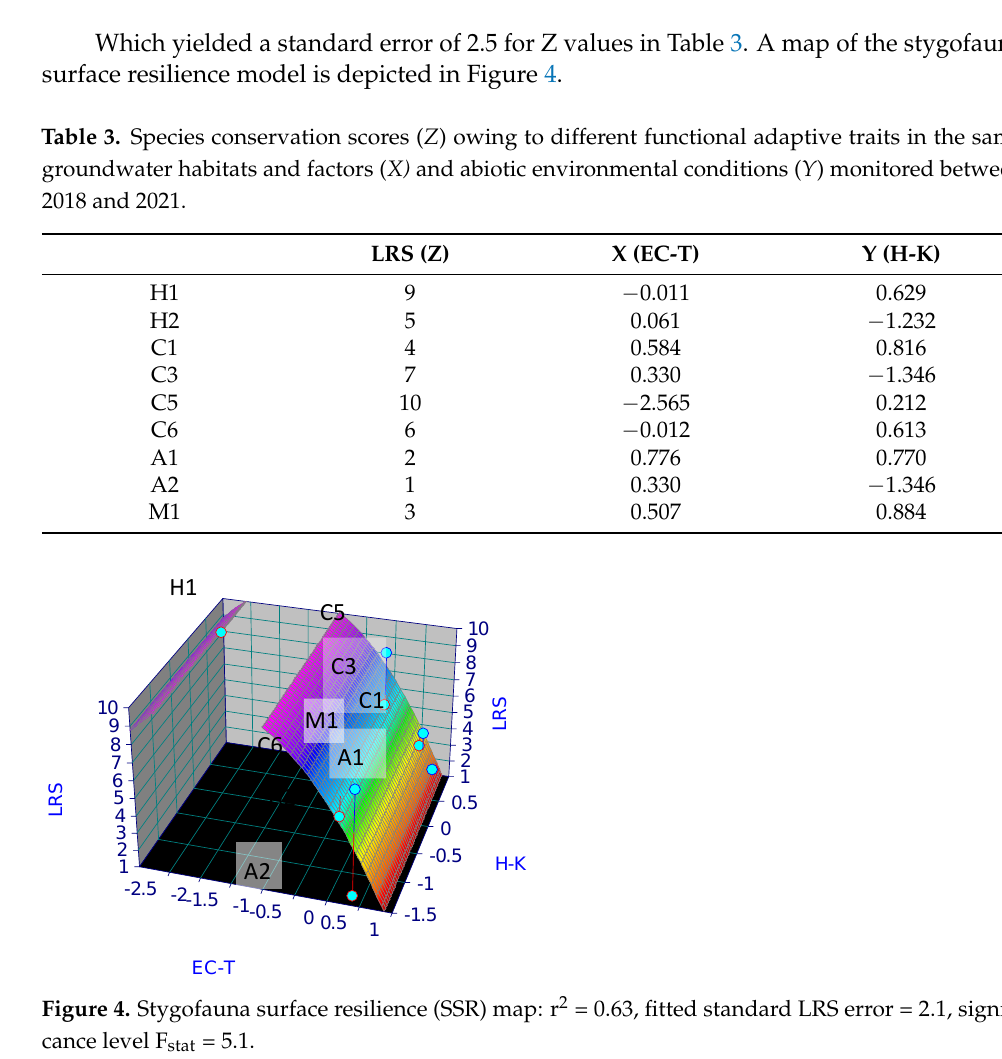
10 of 16 Table 3. Species conservation scores ( Z ) owing to different functional adaptive traits in the same groundwater habitats and factors ( X) and abiotic environmental conditions ( Y ) monitored between 2018 and 2021.